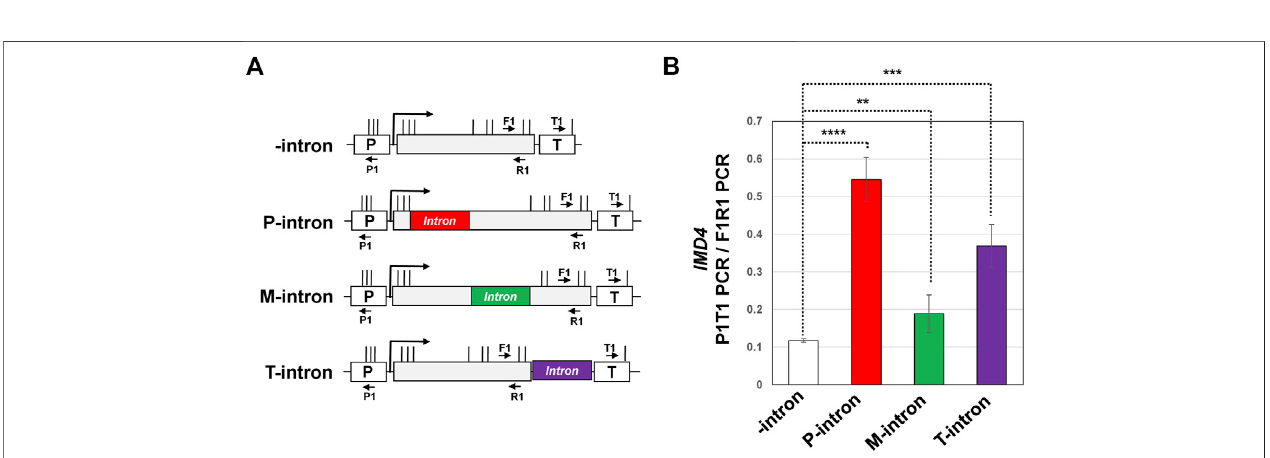
FIGURE2| Positionofanintronwithinthegeneimpactsgeneloopingof IMD4 . (A) Schematicdepictionof IMD4 genewithoutintron(-intron,white),andwith ACT1 intron inserted near the promoter (P-intron, red), in the middle of the gene (M-intron, green) and in the proximity of the terminator (T-intron, purple) region. “ p ” and “ T ” standfor thepromoter and terminator respectively. Verticallines showpositionofrestriction cutsites, while P1,T1, F1and R1arethe positionofprimers used toamplify 3C PCR products. (B) 3Canalysisof IMD4 in the absence of an intron (white bar), and withthe intron inserted near the promoter (red bar), in the middle (green bar) and toward the terminator region of the gene (purple bar). P1T1 PCR represents gene looping signal, while F1R1 PCR represents the loading control that was used to ensure equal amounts of template DNA were present in each 3C PCR reaction. Results presented here represent three biological replicates and six technical replicates. The values and error bars for each condition indicate the mean ± standard deviation. Statistical signi fi cance ( p -values) was determined using the two-tailed paired Student ’ s t -test.Twoasterisks(**)signifya p valueequaltoorsmallerthan0.01( p ≤ 0.01).Threeasterisks(***)indicate p valueequal/smallerthan0.001( p ≤ 0.001).Four asterisks (****) indicate p value equal/smaller than 0.0001 ( p ≤ 0.0001). Any non-signi fi cant difference is represented by ns ( p >